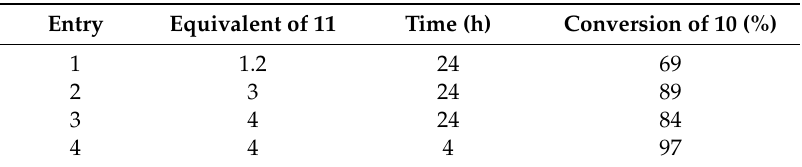
Table 3. Michael addition with an excess of dimethylmalonate (conditions: 1 eq. chalcone, 1.2 eq. ( S ) prolinate TBP + , 2 mL DMF, 50 ◦